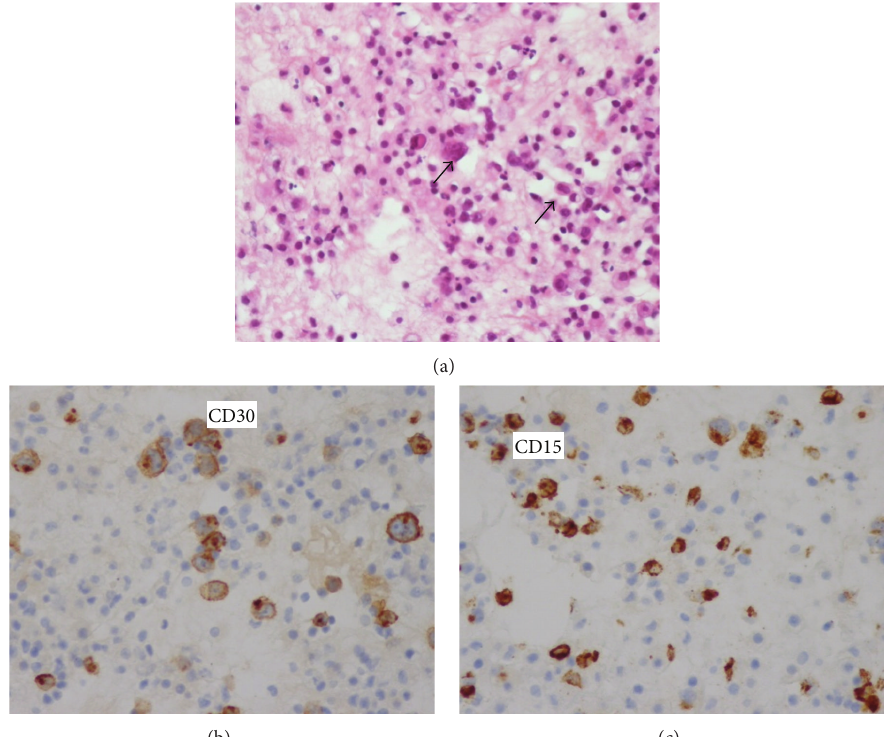
Figure 3: Histopathological examination of pleural fluid: cytological spreading showing atypical cells with cusped nuclei (arrows) on a background rich in neutrophils (magnification × 250) (a), immunocytochemistry expression of CD 30, and CD15 by tumor cells (b and